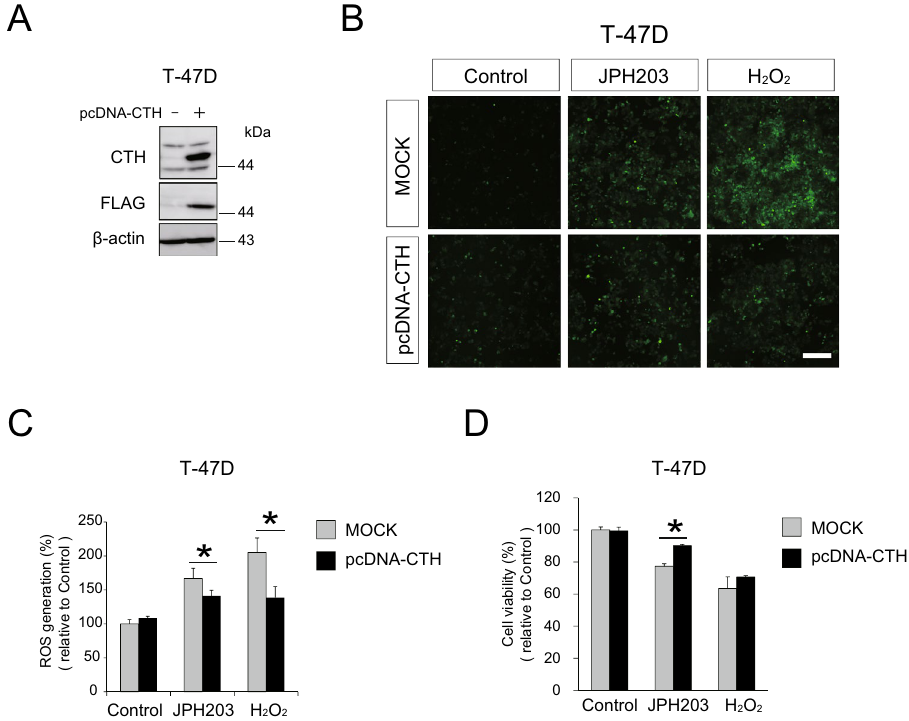
Figure 6. ROS generation and cell viability in response to JPH203 in CTH overexpressed T-47D cells. ( A ) 1 μg of pcDNA3.1- CTH vector or mock vector were transiently transfected into T-47D cells for 24 h. CTH expression and FLAG were confirmed by western blot. ( B ) After mock or CTH overexpressed T-47D cells were incubated in the absence or presence of 5 μM JPH203 for 48 h, DCFH-DA was applied to observe generation of ROS. Scale bar = 100 μm. ( C ) Quantification of intracellular ROS level of ( B ) by microplate reader. *p < 0.05. ( D ) Cell viability of mock or CTH overexpressed T-47D after incubation in the absence or presence of 5 μM JPH203 for 48 h was evaluated by MTT assay. *p < 0.05.